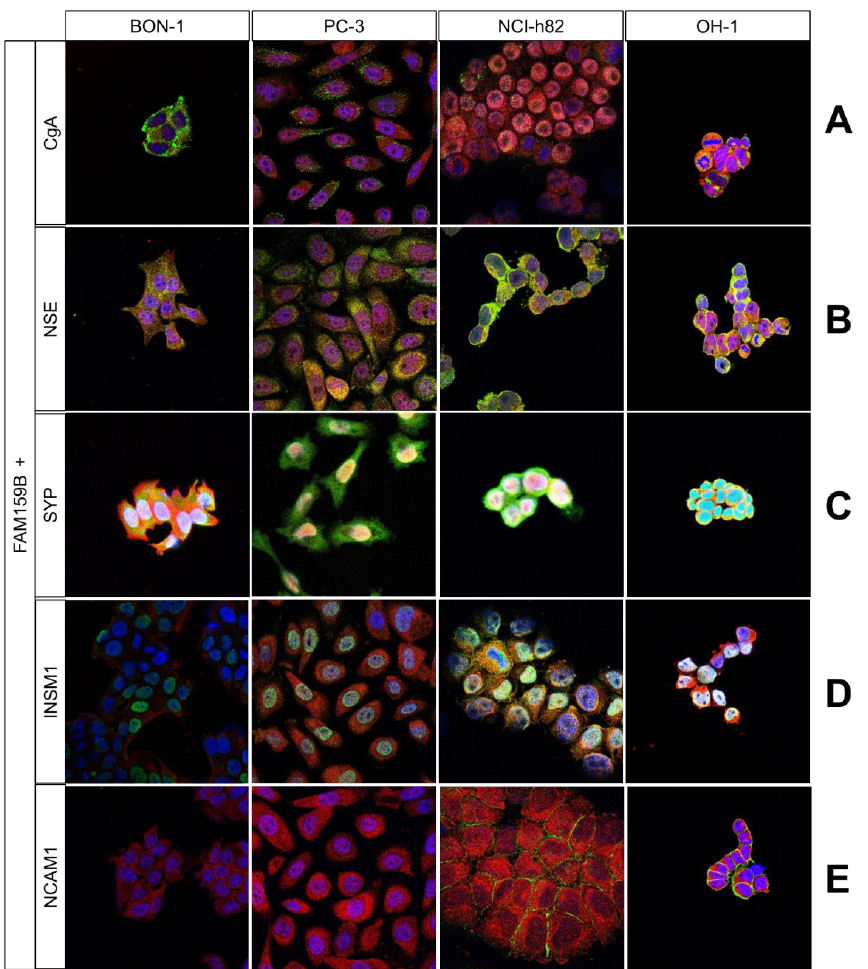
Figure 2. Double-labelling immunocytochemical analysis of FAM159B and chromogranin A (CgA; A ), neuron specific enolase (NSE; B ), synaptophysin (SYP; C ), insulinoma-associated protein 1 (INSM1; D ), or neural cell adhesion molecule 1 (NCAM1; E ) expression in BON-1, PC-3, NCI-h82, and OH-1 cells. ( A , B , D , E ): Labelling for FAM159B was visualised using Cy3-conjugated anti-rabbit antibody (red). Labelling for CgA, NSE, INSM1, and NCAM1 was visualised using Alexa Fluor 488-conjugated anti-mouse antibody (green). ( C ): Labelling for FAM159B was visualised using FITC-conjugated anti-rabbit antibody (green). Labelling for synaptophysin was visualised using Cy3-conjugated anti-rabbit antibody (red). Overlapping expression is shown in orange/yellow colour. All photomicrographs were taken at the same magnification. Scale bar: 100 µm.